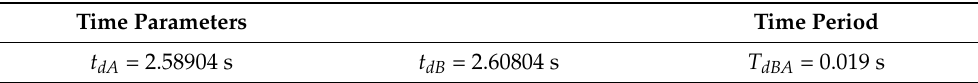
Table 9. Time periods and their parameters according to Figure 24.